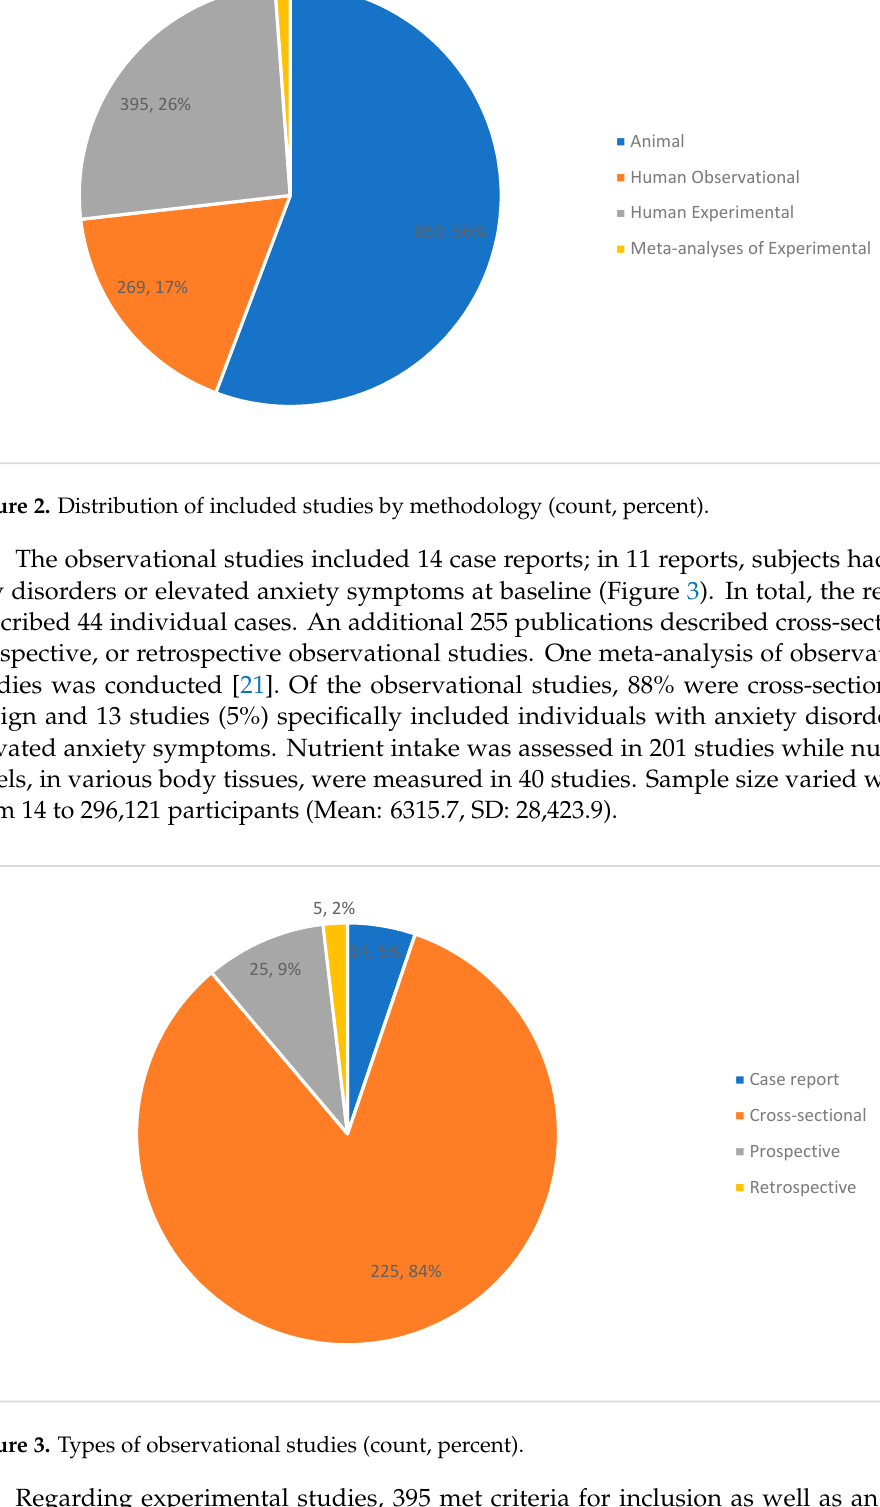
Figure 3. Types of observational studies (count, percent).